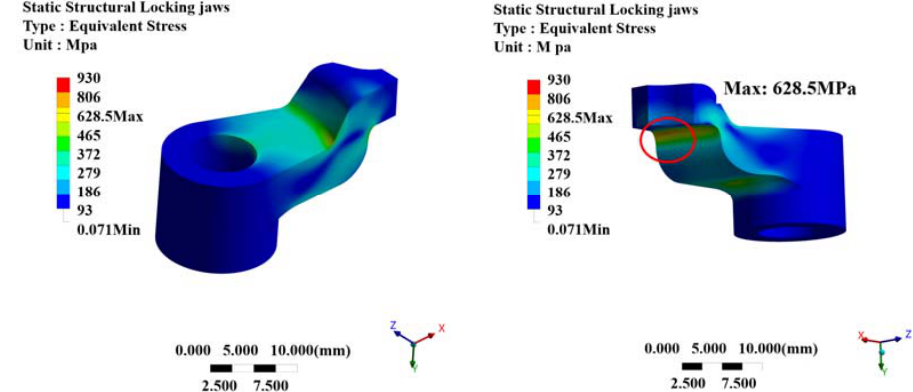
Figure 8. Optimized locking jaw stress distribution.